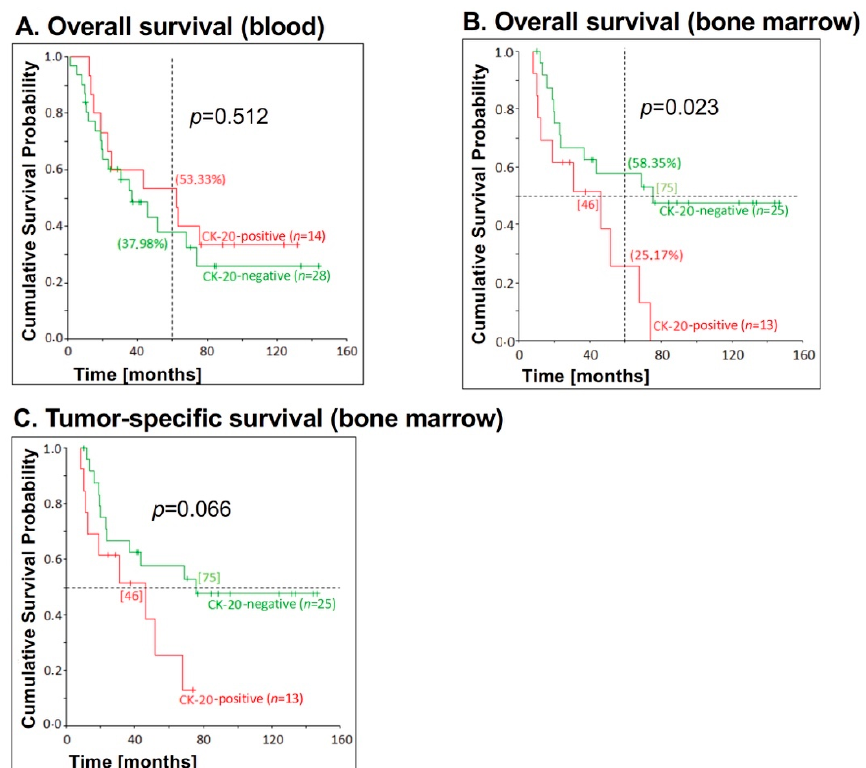
Figure 3. Correlation between CK20 positivity in blood and bone marrow samples, respectively, and survival for patients with esophageal carcinoma UICC stage I and II. CK20 positivity in ( A ) blood ( n = 20) and ( B , C ) bone marrow ( n = 13) samples of EC patients with lower tumor stages were assessed by RT-PCR and correlated with ( A ) overall survival in blood samples, ( B ) overall survival and ( C ) tumor-specific survival in bone marrow samples. The p -values for the comparison of the cumulative survival probabilities of the two groups (CK20-positive versus CK20-negative) were calculated using the log-rank test. On the vertical dotted line at 60 months, the percentages for 5-year overall survival are shown in brackets. On the horizontal dotted line at the cumulative survival probability of 0.5 is the median survival and is given in months in square brackets.